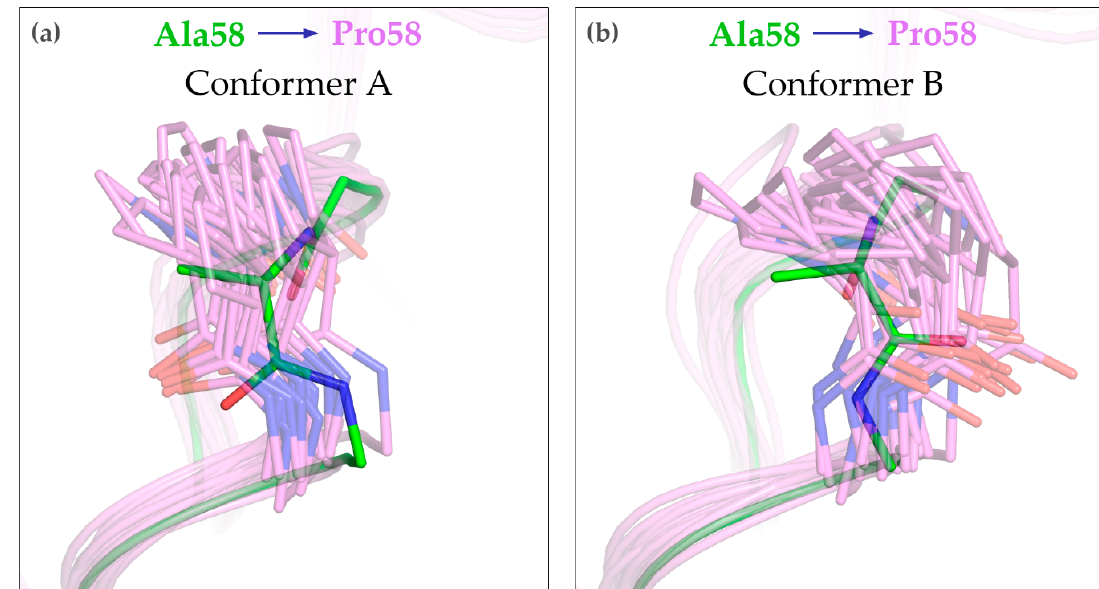
Figure 5. Structure of the conformers A ( a ) and B ( b ) of the Aβ-Bβ loop in the A58P mutant, as observed in MD simulations. The original structure of CagFbFP (PDB ID 6RHF) is shown in green, and trajectory snapshots of the A58P mutant are shown in magenta. 20 exemplary conformations for each alternative conformation of the Pro58 backbone are shown. Most notably, the position of the side chain C β atom is different between Ala58 and Pro58.